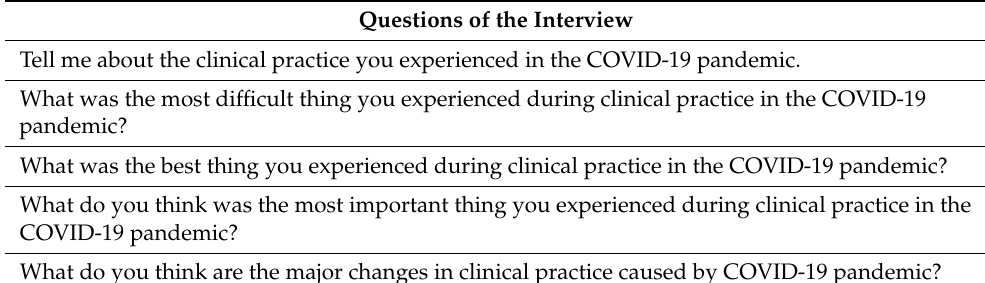
Table 1. The semi-structured interview